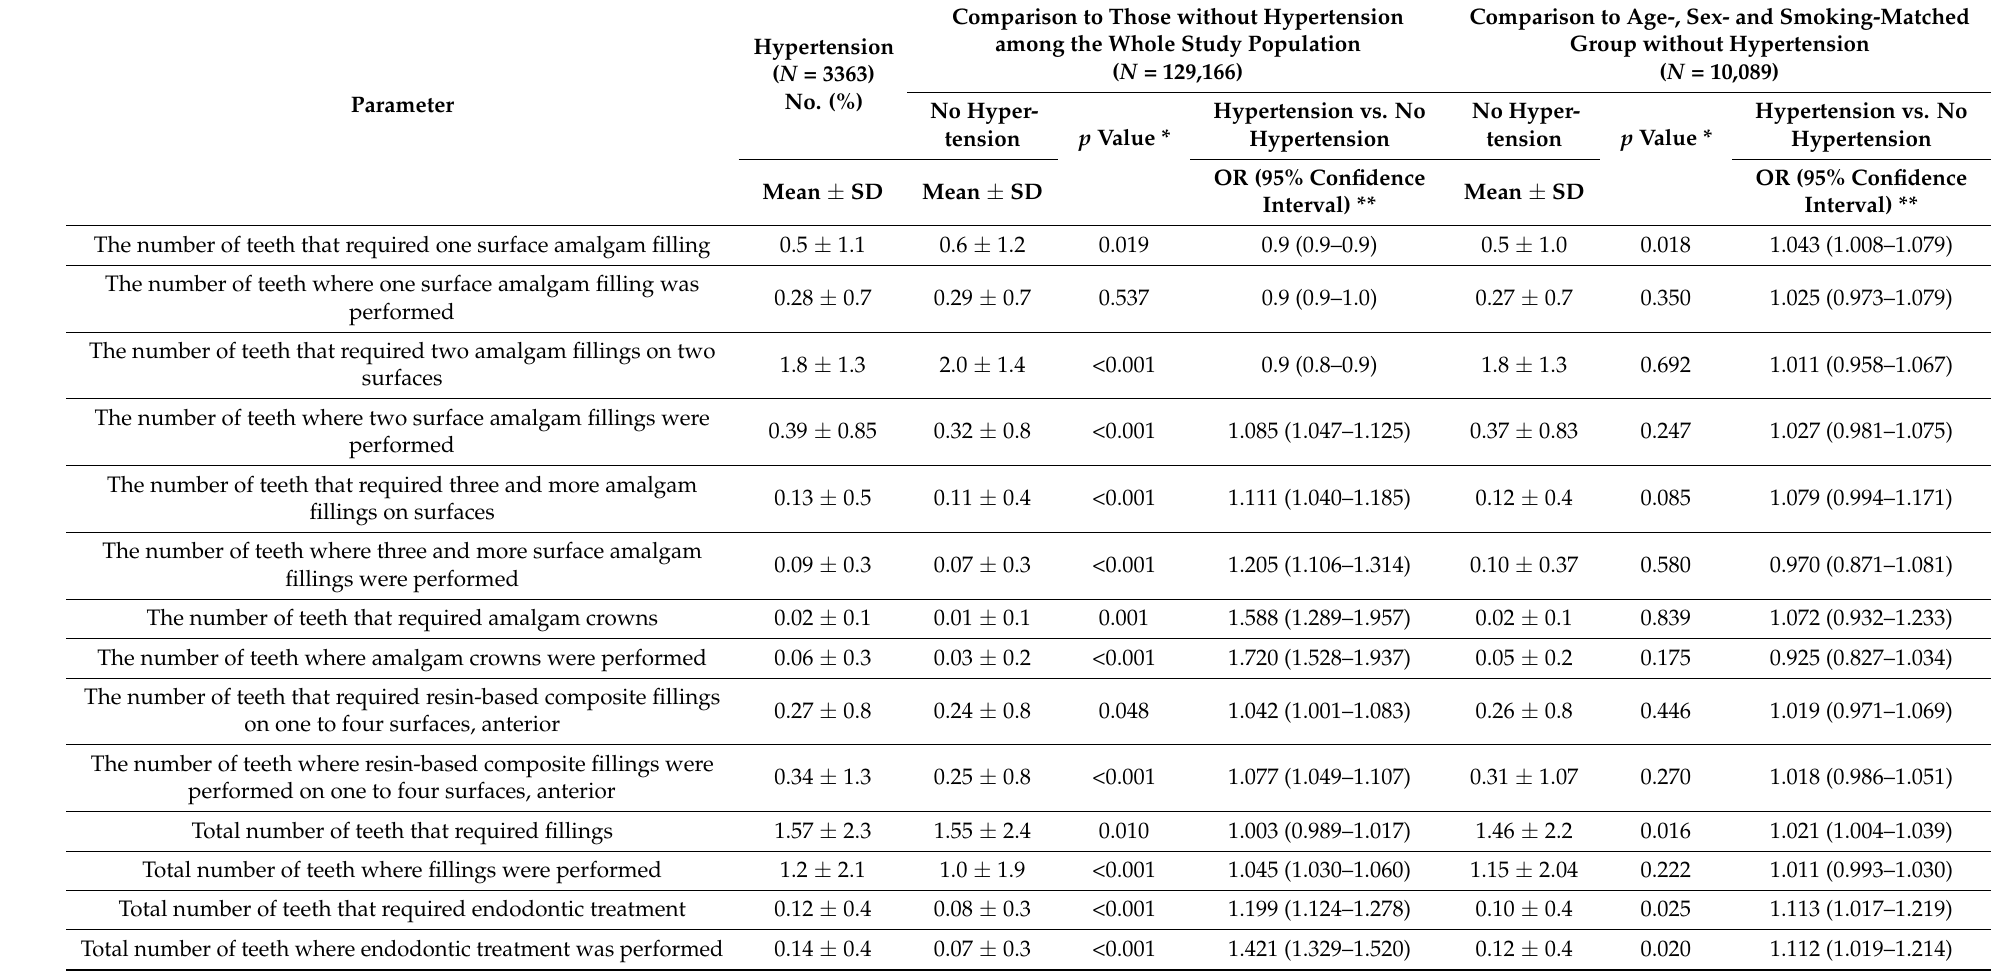
Table 4. Requirements and performance of dental procedures according to hypertension diagnosis among the study population and among the age-, sex- and smoking-matched sub-population. Parameter